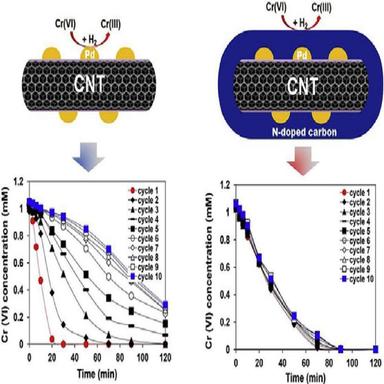
The proposed reaction scheme of Cr(VI) removed by Pd/Fe-NMC (,).